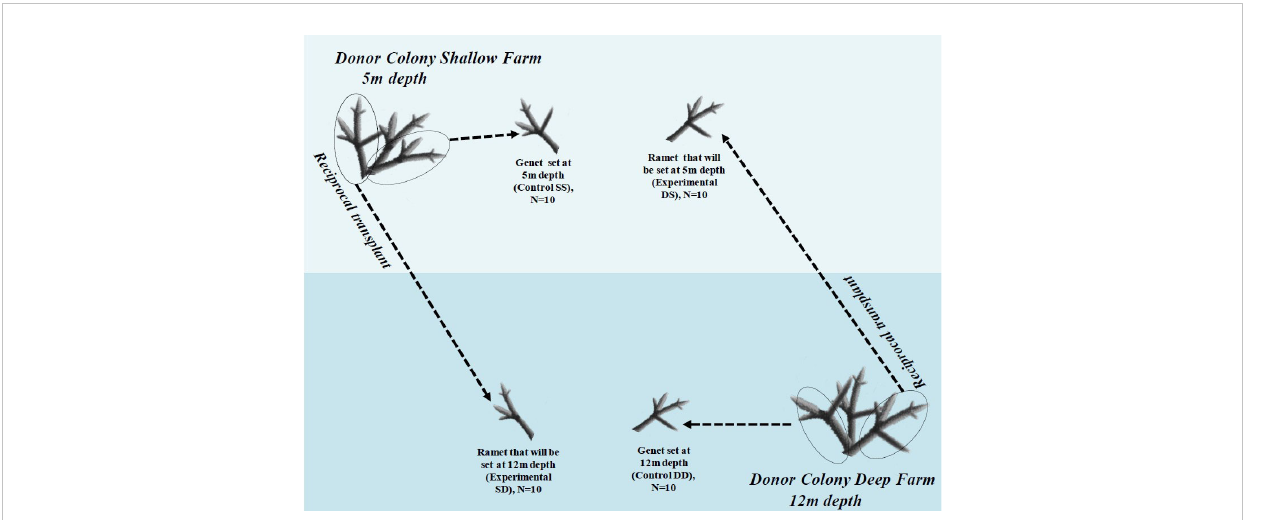
FIGURE 1 Diagram illustrating the experimental design procedures. DD represent control genet colonies from deep water farm; SS represent control genet colonies from shallow water farms. DS represents ramet colonies transplanted from deep to shallow, and SD represents ramet colonies transplanted from shallow to deep coral